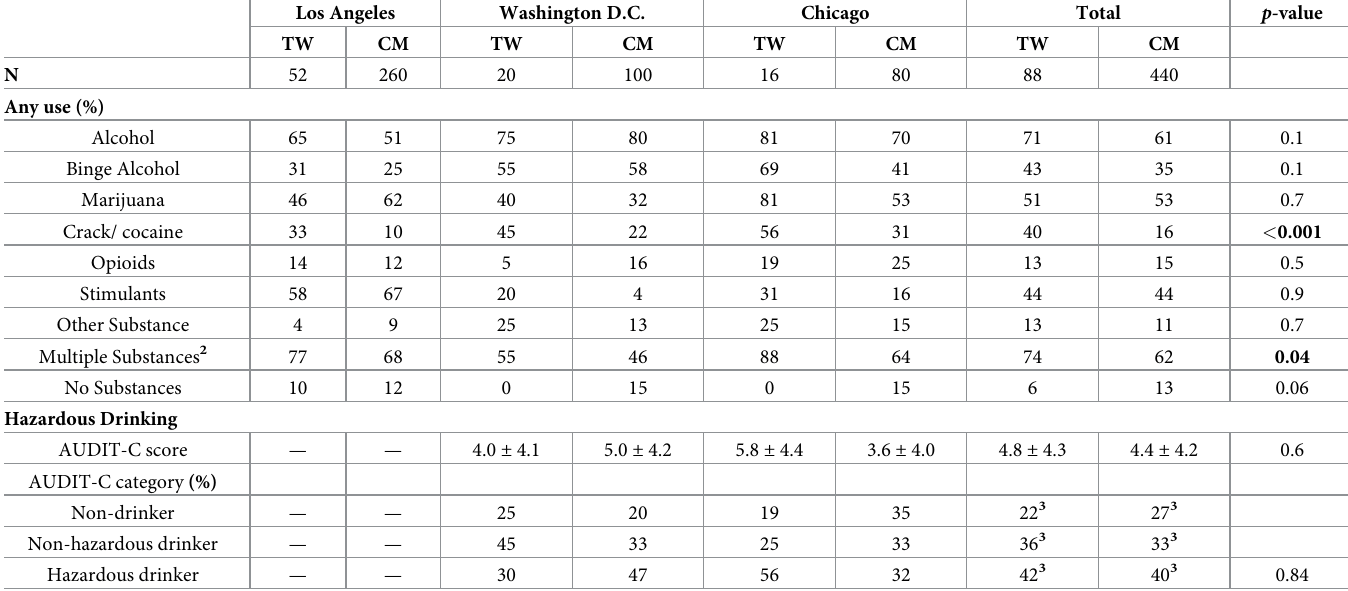
Table 3. Substance use during reference period 1 , comparing transgender women and cisgender men.